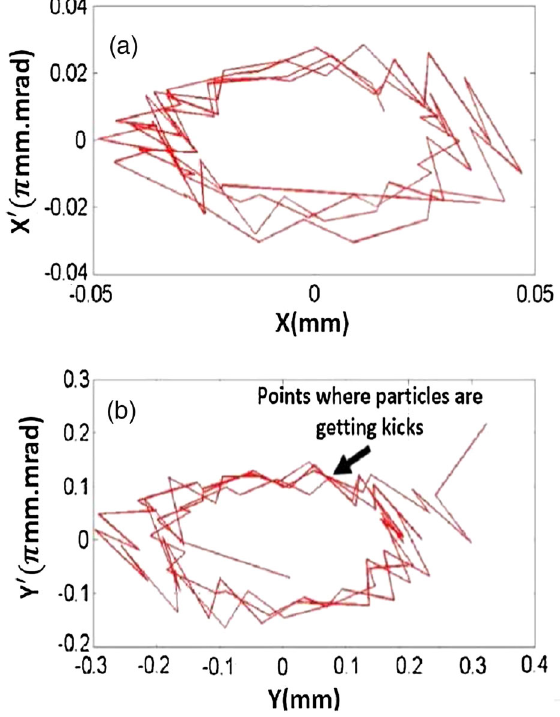
FIG. 13. Phase space trajectory of a lost particle along propagation direction in: (a) xx 0 and (b) yy 0 . It can be seen that the particle remains confined in x but is lost in y .